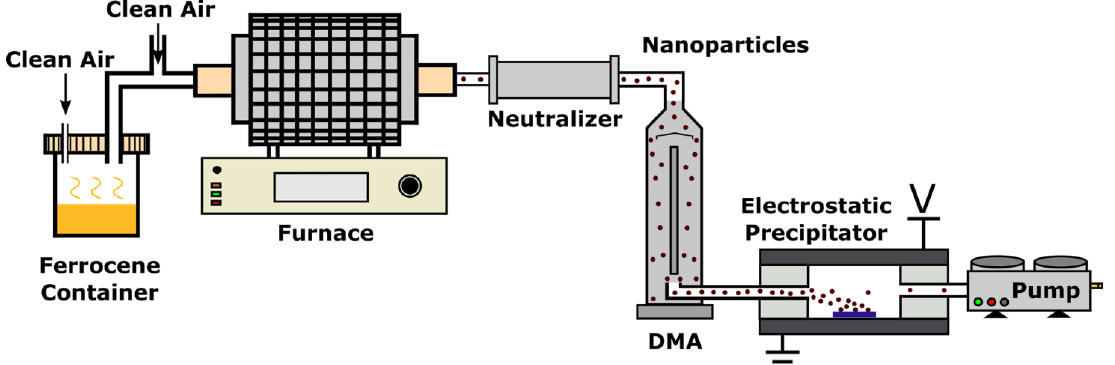
Figure 4. Experimental setup schematic for continuous Fe 2 O 3 nanoparticle generation, size selection, and collection. The ferrocene vapor is carried by particle-free air and enters the tube furnace set to 700 ◦ C, where the ferrocene is calcined into Fe 2 O 3 nanoparticles (Fe-oNPs) and flows to the downstream. After being charged by a neutralizer, the polydisperse Fe-oNPs are size-selected by DMA, and finally deposited onto a substrate in the electrostatic